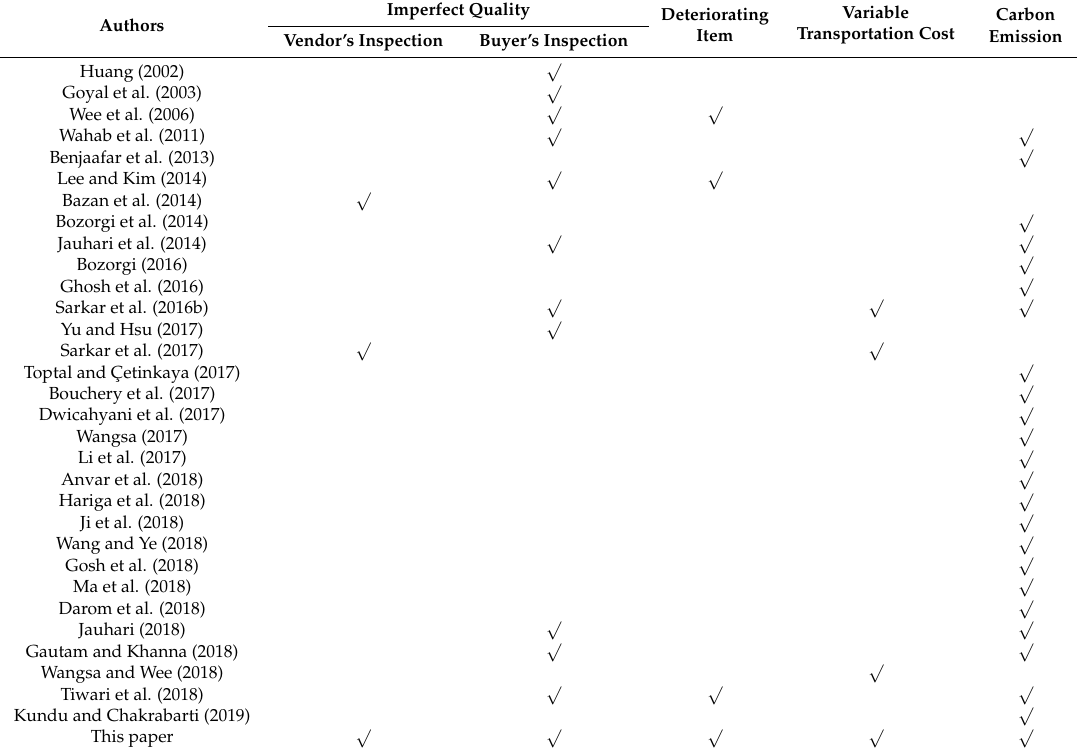
Table 1. Gap analysis with existing